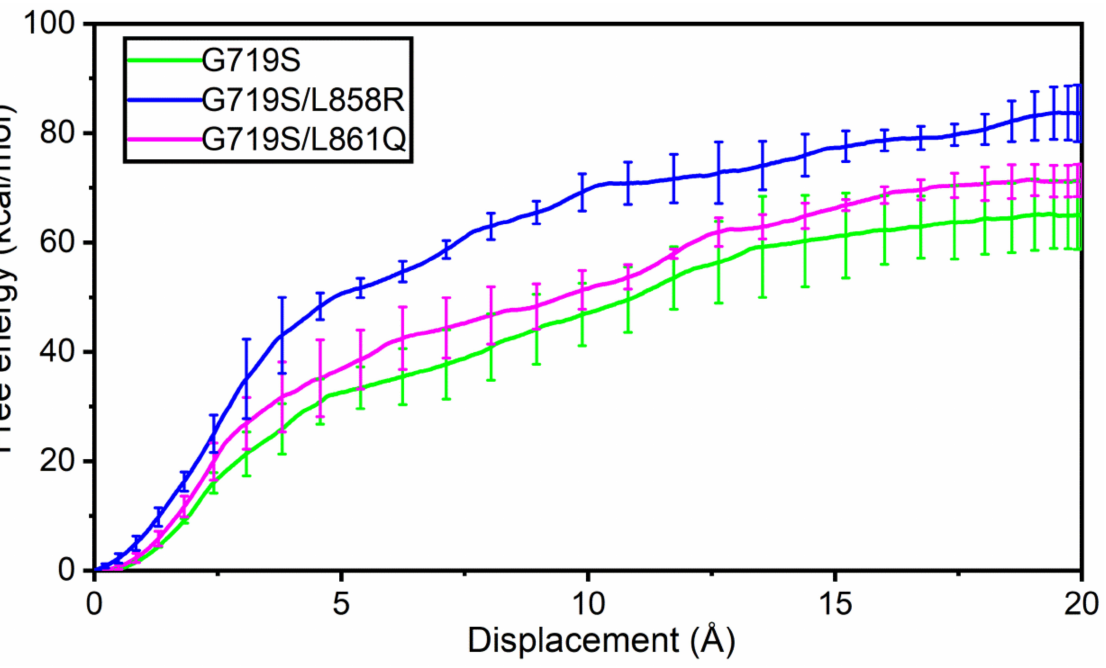
Figure 9. The average work profile for IRE dissociation with error bars of each complex system during the SMD simulations. The bars represent the standard deviation of the external